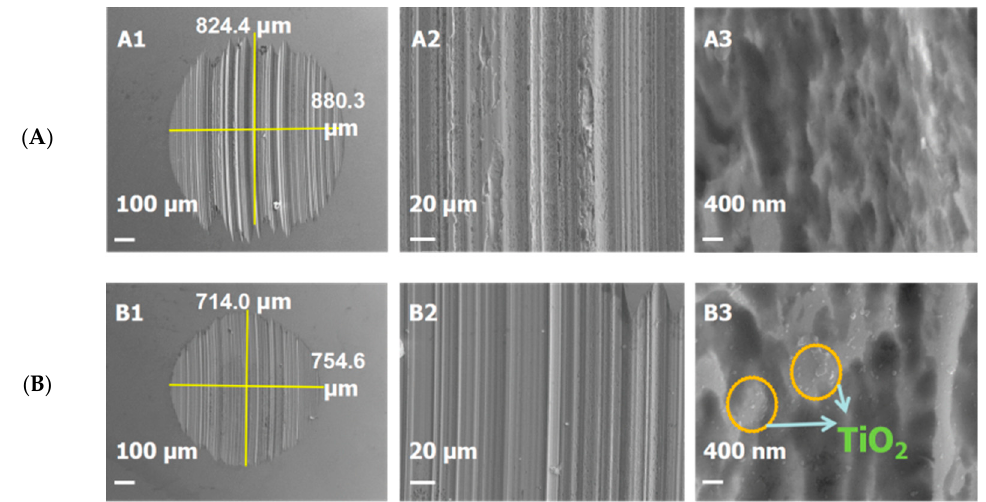
Figure 12. SEM of surface lubricated with product base oil ( A ) and product TiO 2 nano-lubricant ( B